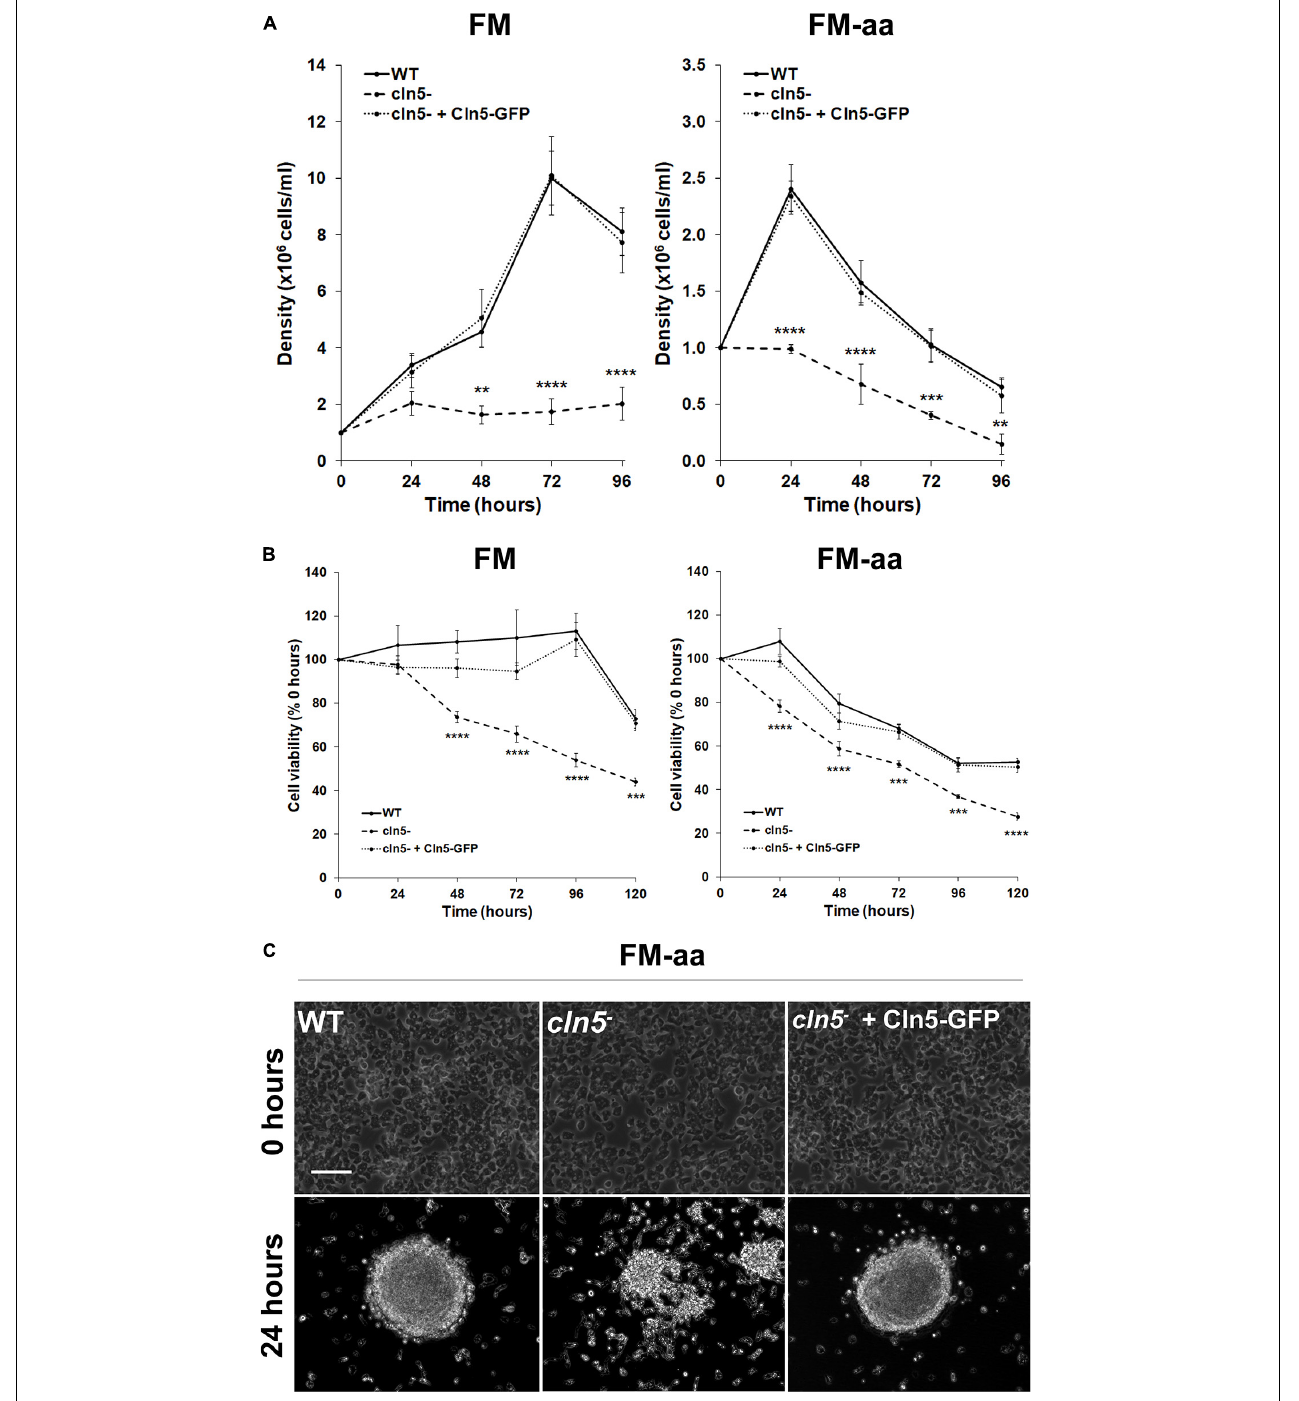
FIGURE 2 | Effect of cln5 -deficiency on cell proliferation and viability in FM and FM-aa. (A) WT, cln5 − , and cln5 − + Cln5-GFP cells were placed in FM or FM-aa at a density of 1.0 × 10 5 cells/ml. Cell densities were measured every 24 h for 96 h. Data presented as mean density ± SEM ( n ≥ 4). Statistical significance was assessed using two-way ANOVA followed by Bonferroni’s multiple comparisons test. ** p -value < 0.01, *** p -value < 0.001, and **** p -value < 0.0001 at the indicated time points vs. WT. (B) Cells were grown in FM and FM-aa as described in panel (A) . The CellTiter-Glo Luminescent Cell Viability Assay was used to quantify cell viability at the indicated time points. Statistical significance was determined using two-way ANOVA followed by Bonferroni’s multiple comparisons test. *** p -value < 0.001 and **** p -value < 0.0001 at the indicated time points vs. WT. (C) Cells (20 × 10 6 total) were harvested from HL5 suspension and placed in a 100 × 15 mm Petri dish containing HL5. After 1 h, the HL5 was removed and replaced with FM-aa. Images were taken after 24 h and are representative of four independent experiments. Scale bar = 50 µ m.